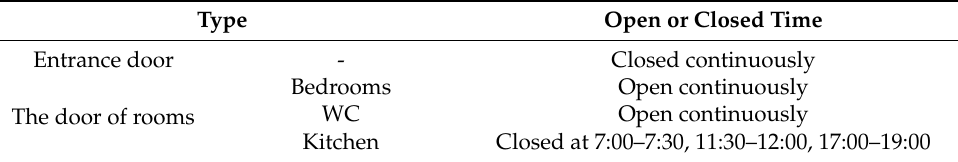
Table 6. Door open and closed times in the